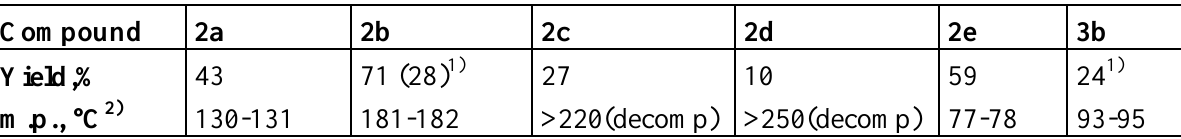
Table 1. Yields and Melting Points of Compounds 2a-e , 3b